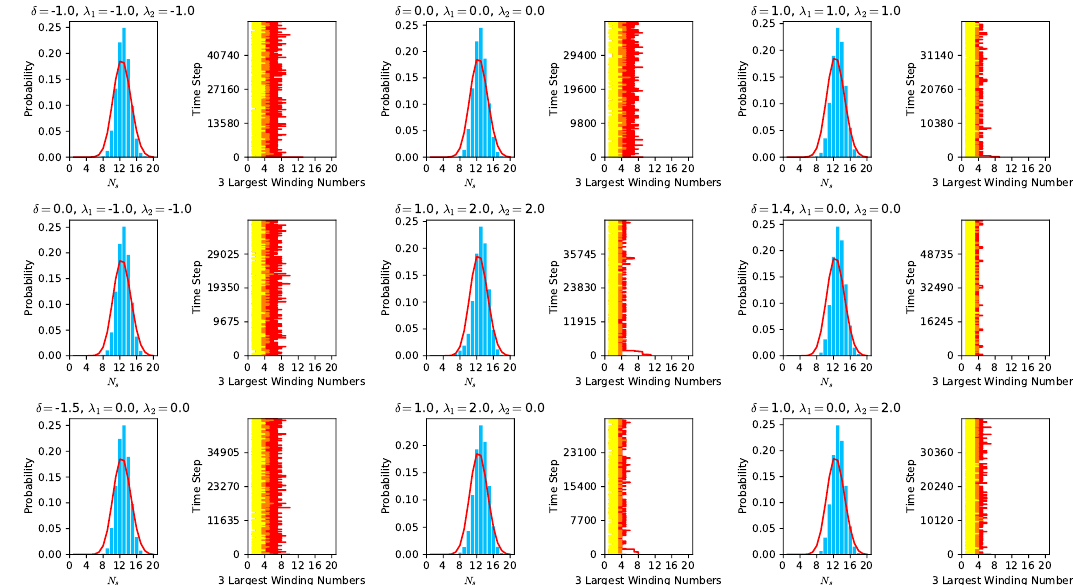
Figure 21: Random walk results for different values of δ , λ plot are the probabilities: the random walk probability to be in a microstate with N strings is plotted in blue, while the fractional degeneracy of microstates is in red. On the right of each plot we display the three largest winding numbers of the strings in red, orange, and yellow in descending order, respectively, at each time step in the random walk. In all graphs, N = 20 and γ =